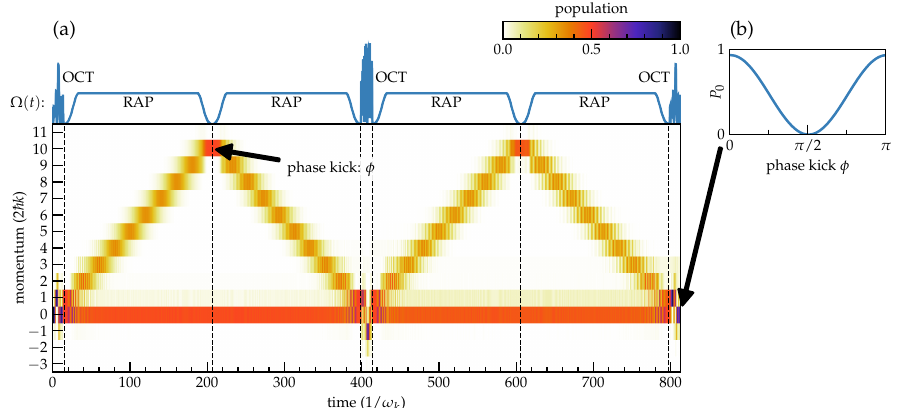
Figure 7. ( a ) Momentum space dynamics for an interferometric scheme using optimized pulses (OCT) in combination with rapid adiabatic passage (RAP). The optimized pulses are those shown in Figure 6b,c and implement the initial splitting, the center swap, and the final recombination between levels 0 and 1 . These are combined with RAP pulses similar to the one shown in Figure 3a, | (cid:105) | (cid:105) transferring population between 1 and 10 . All pulse amplitudes are shown to scale at the top | (cid:105) | (cid:105) of the panel. ( b ) The final time population in 0 if an instantaneous phase kick is applied to the | (cid:105) 10 component of the wave function at maximum separation to account for the free time evolution | (cid:105) starting at t = 206.8 / ω k and t = 605.6 / ω k (not shown). The maximum population at φ = 0 or φ = π is 0.934 and the minimum population at φ = π is 2